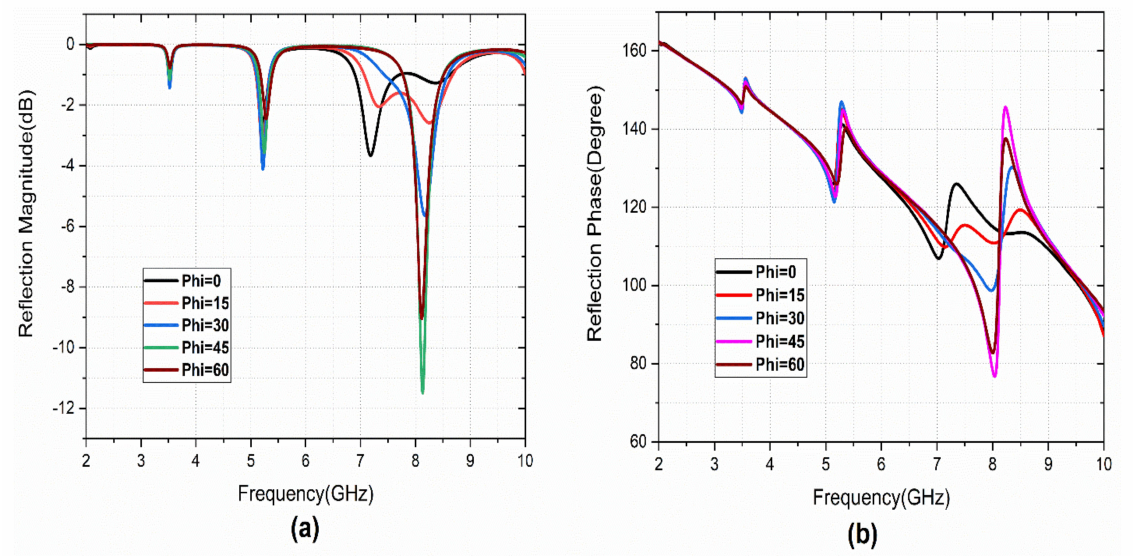
Figure 7. Reflection characteristics under Phi variation: ( a ) magnitude, ( b )